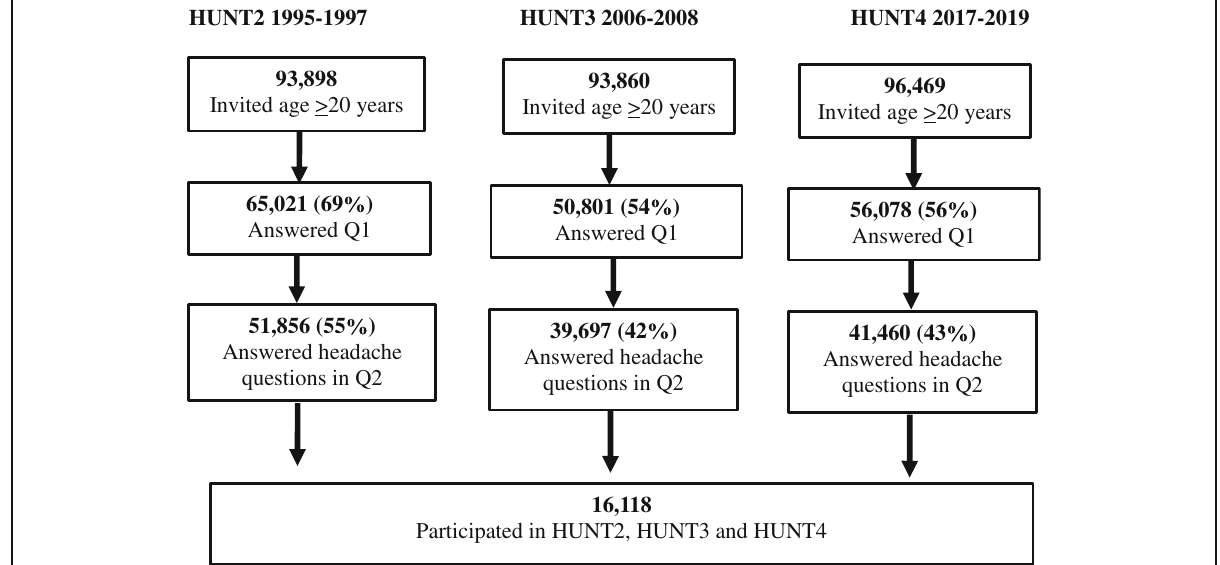
Fig. 1 The flow of participants in HUNT2, HUNT3 and